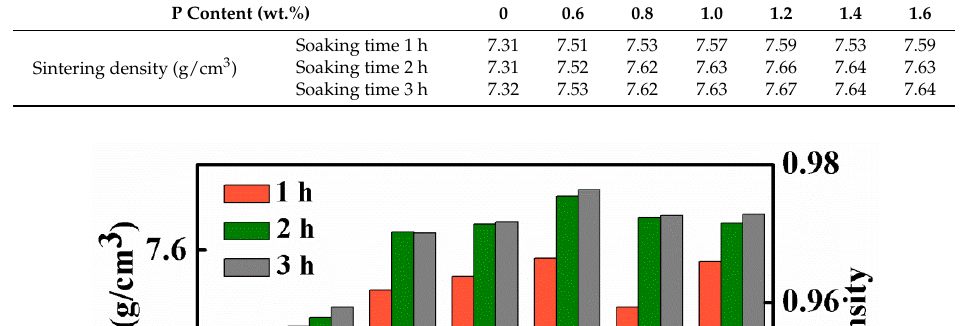
Table 2. A summary of sintering densities of Fe-x P (x = 0, 0.6, 0.8, 1.0, 1.2, 1.4 and 1.6 wt.%) samples sintered at 1000 °C for different time.